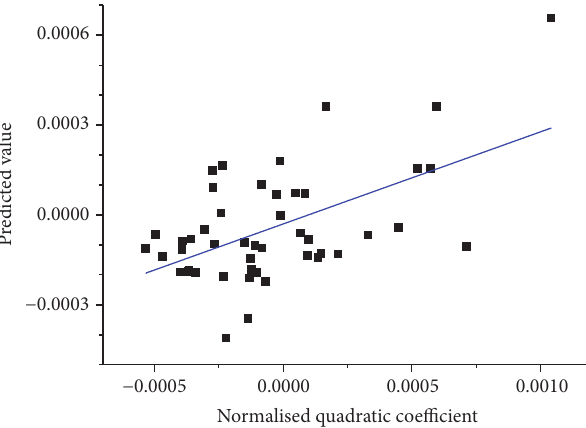
Figure 6: Normalised quadratic coefficient, as predicted by the linear model of (11) and (13), as a function of the observed